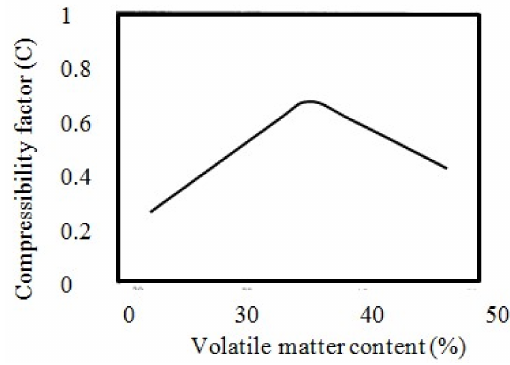
Figure 15. Volatile matter content-dependent compressibility factor of coal